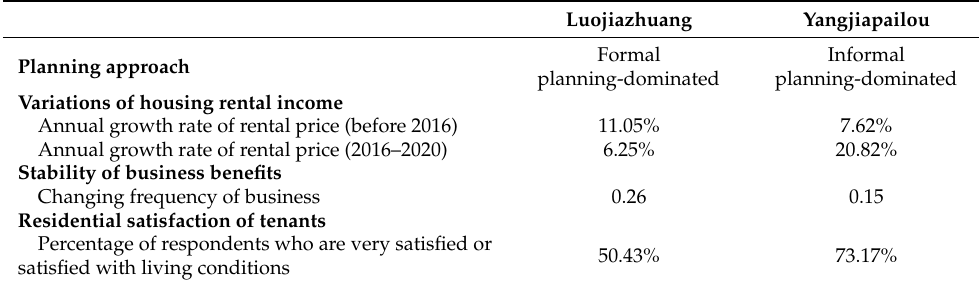
Table 5. The comparison of Luojiazhuang and